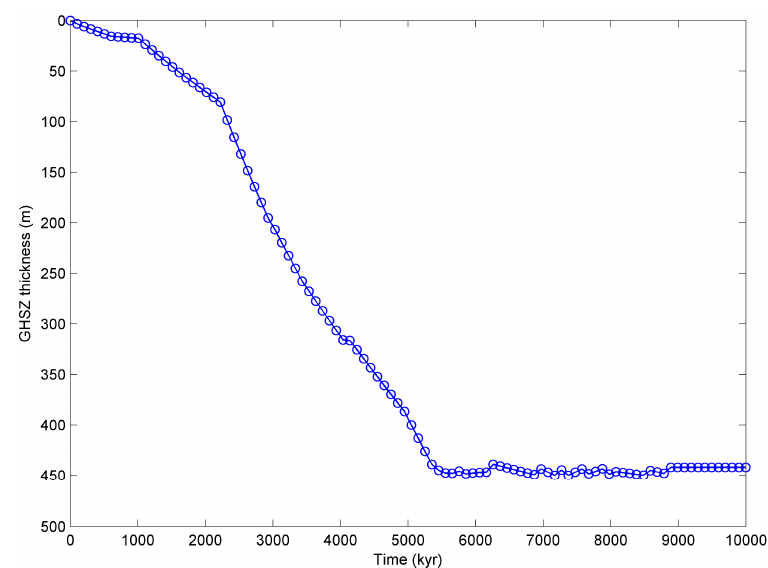
Figure 10. Gas hydrate stability zone (GHSZ) evolution in time for the Scenario 2a (no flux boundary conditions, variable sedimentation rate over time).